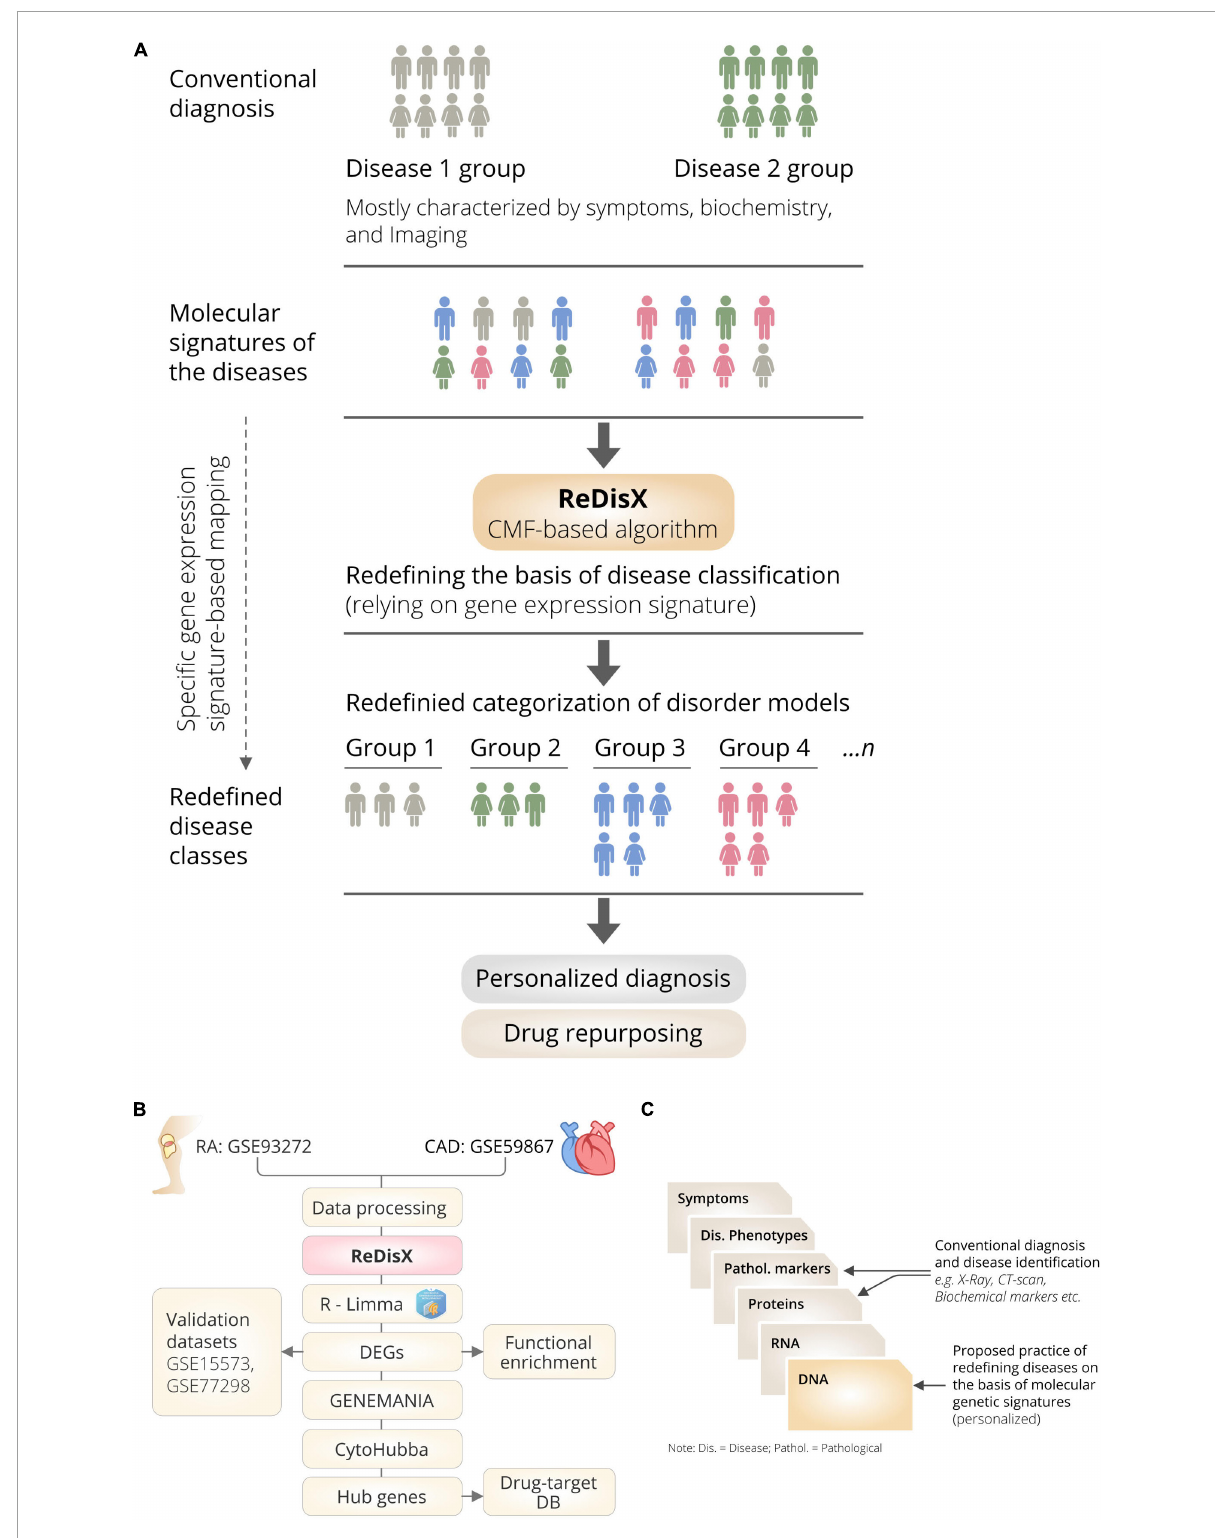
FIGURE1 The schematic illustration of the ReDisX framework and its functional features. (A) ReDisX-based approach to redefine the disease diagnosis compared to the conventional diagnosis, (B) functional pipeline for the ReDisX-based analyses for RA and CAD datasets, (C) strategic significance of ReDisX framework over the conventional diagnosis